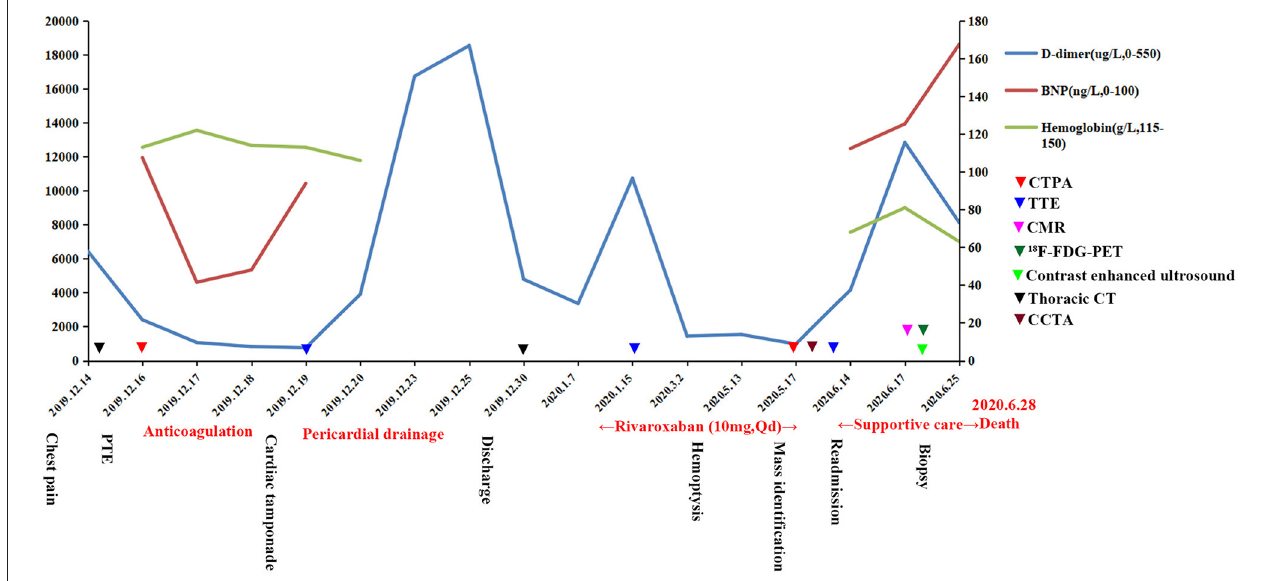
FIGURE 5 | Progression and examination of the clinical course. PTE, pulmonary thromboembolism; BNP, brain natriuretic peptide; CTPA, computed tomography pulmonary angiography; TTE, transthoracic echocardiogram; CMR, cardiac magnetic resonance; PET, positron emission tomography; CCTA, coronary computed tomography